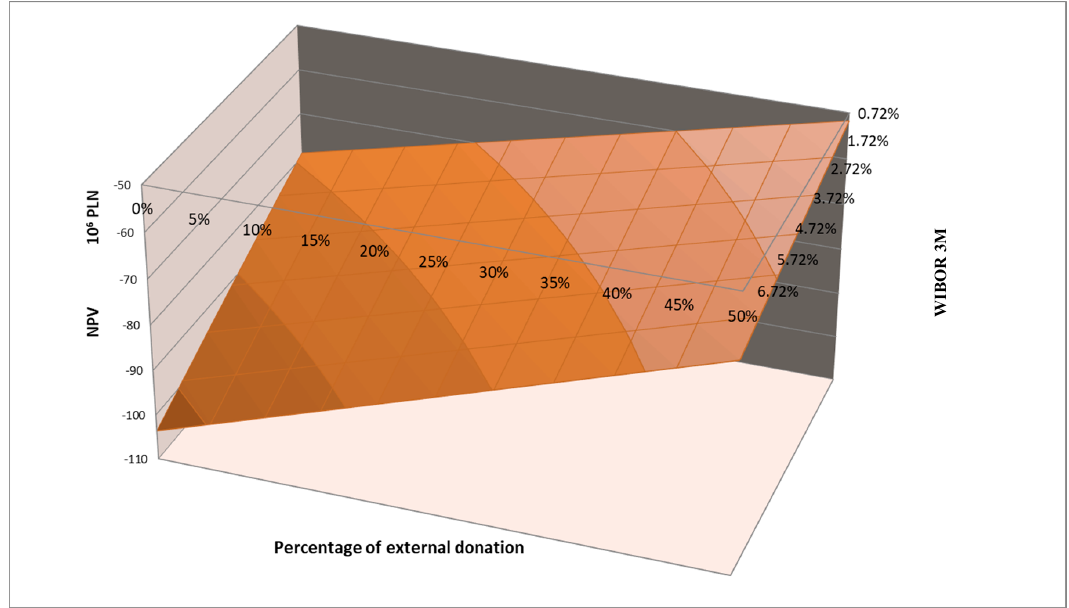
Figure 6. The NPV sensitivity to shifts in financing conditions affected by external donations and changes of the reference interest rate (possible financing scenarios).